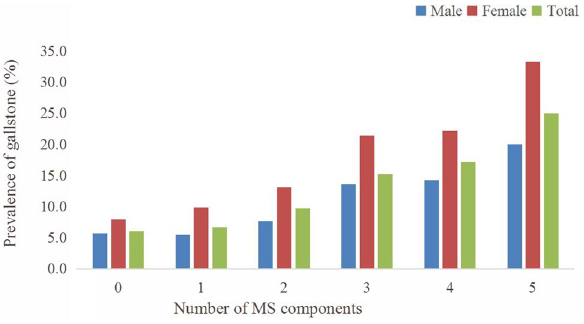
Figure 1. The association between the prevalence of GSD and the number of MetS